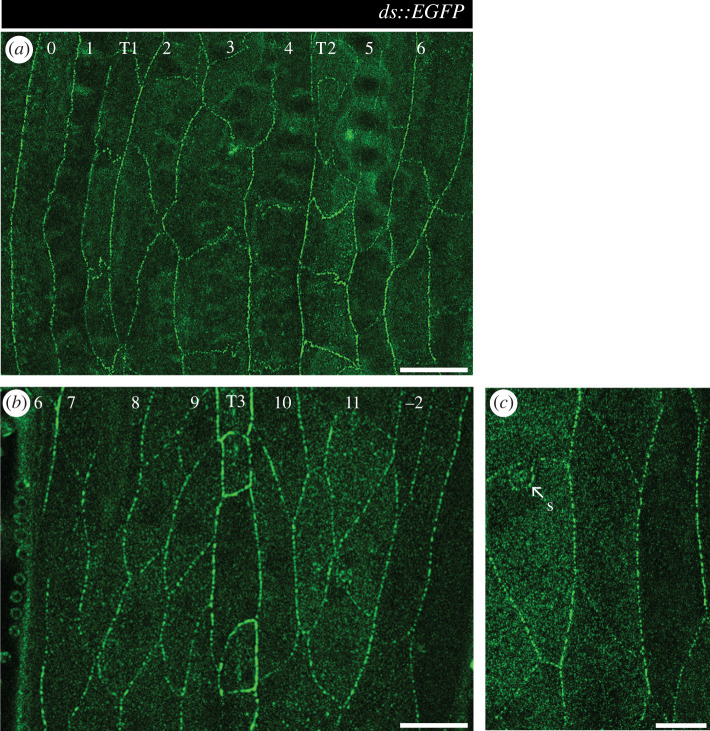
Ds localization in the larval ventral abdomen. Larvae expressing ds::EGFP from the tagged endogenous ds locus [14] show a ubiquitous punctate pattern of fluorescence that concentrates on plasma membranes. (a) Denticulate and (b) undenticulate areas of early-second-stage larvae; the cell rows exhibit no obvious differences in ds expression or distribution, with the exception of the strong signal around T3 tendon cells. (c) Detail of Ds localization in puncta at the cell membrane. 0 to 6, denticle cell rows. 7 to −2, undenticulate cell rows. S, sensory cell. T1, T2, T3, tendon cell rows. Scale bars: 20 µm (a,b), 10 µm (c).